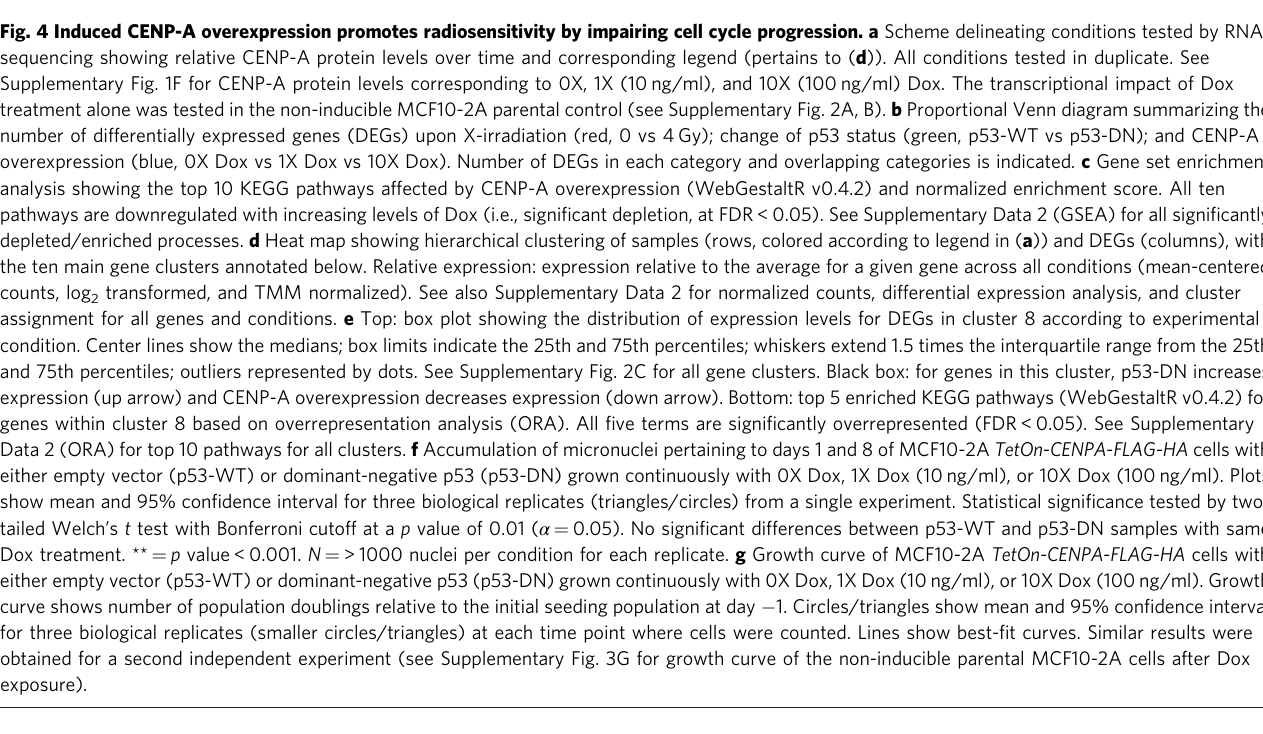
Fig. 4 Induced CENP-A overexpression promotes radiosensitivity by impairing cell cycle progression. a Scheme delineating conditions tested by RNA- sequencing showing relative CENP-A protein levels over time and corresponding legend (pertains to ( d )). All conditions tested in duplicate. See Supplementary Fig. 1F for CENP-A protein levels corresponding to 0X, 1X (10 ng/ml), and 10X (100 ng/ml) Dox. The transcriptional impact of Dox treatment alone was tested in the non-inducible MCF10-2A parental control (see Supplementary Fig. 2A, B). b Proportional Venn diagram summarizing the number of differentially expressed genes (DEGs) upon X-irradiation (red, 0 vs 4 Gy); change of p53 status (green, p53-WT vs p53-DN); and CENP-A overexpression (blue, 0X Dox vs 1X Dox vs 10X Dox). Number of DEGs in each category and overlapping categories is indicated. c Gene set enrichment analysis showing the top 10 KEGG pathways affected by CENP-A overexpression (WebGestaltR v0.4.2) and normalized enrichment score. All ten pathways are downregulated with increasing levels of Dox (i.e., signi fi cant depletion, at FDR < 0.05). See Supplementary Data 2 (GSEA) for all signi fi cantly depleted/enriched processes. d Heat map showing hierarchical clustering of samples (rows, colored according to legend in ( a )) and DEGs (columns), with the ten main gene clusters annotated below. Relative expression: expression relative to the average for a given gene across all conditions (mean-centered counts, log 2 transformed, and TMM normalized). See also Supplementary Data 2 for normalized counts, differential expression analysis, and cluster assignment for all genes and conditions. e Top: box plot showing the distribution of expression levels for DEGs in cluster 8 according to experimental condition. Center lines show the medians; box limits indicate the 25th and 75th percentiles; whiskers extend 1.5 times the interquartile range from the 25th and 75th percentiles; outliers represented by dots. See Supplementary Fig. 2C for all gene clusters. Black box: for genes in this cluster, p53-DN increases expression (up arrow) and CENP-A overexpression decreases expression (down arrow). Bottom: top 5 enriched KEGG pathways (WebGestaltR v0.4.2) for genes within cluster 8 based on overrepresentation analysis (ORA). All fi ve terms are signi fi cantly overrepresented (FDR < 0.05). See Supplementary Data 2 (ORA) for top 10 pathways for all clusters. f Accumulation of micronuclei pertaining to days 1 and 8 of MCF10-2A TetOn-CENPA-FLAG-HA cells with either empty vector (p53-WT) or dominant-negative p53 (p53-DN) grown continuously with 0X Dox, 1X Dox (10 ng/ml), or 10X Dox (100 ng/ml). Plots show mean and 95% con fi dence interval for three biological replicates (triangles/circles) from a single experiment. Statistical signi fi cance tested by two- tailed Welch ’ s t test with Bonferroni cutoff at a p value of 0.01 ( α = 0.05). No signi fi cant differences between p53-WT and p53-DN samples with same Dox treatment. ** = p value < 0.001. N = > 1000 nuclei per condition for each replicate. g Growth curve of MCF10-2A TetOn-CENPA-FLAG-HA cells with either empty vector (p53-WT) or dominant-negative p53 (p53-DN) grown continuously with 0X Dox, 1X Dox (10 ng/ml), or 10X Dox (100 ng/ml). Growth curve shows number of population doublings relative to the initial seeding population at day − 1. Circles/triangles show mean and 95% con fi dence interval for three biological replicates (smaller circles/triangles) at each time point where cells were counted. Lines show best- fi t curves. Similar results were obtained for a second independent experiment (see Supplementary Fig. 3G for growth curve of the non-inducible parental MCF10-2A cells after Dox